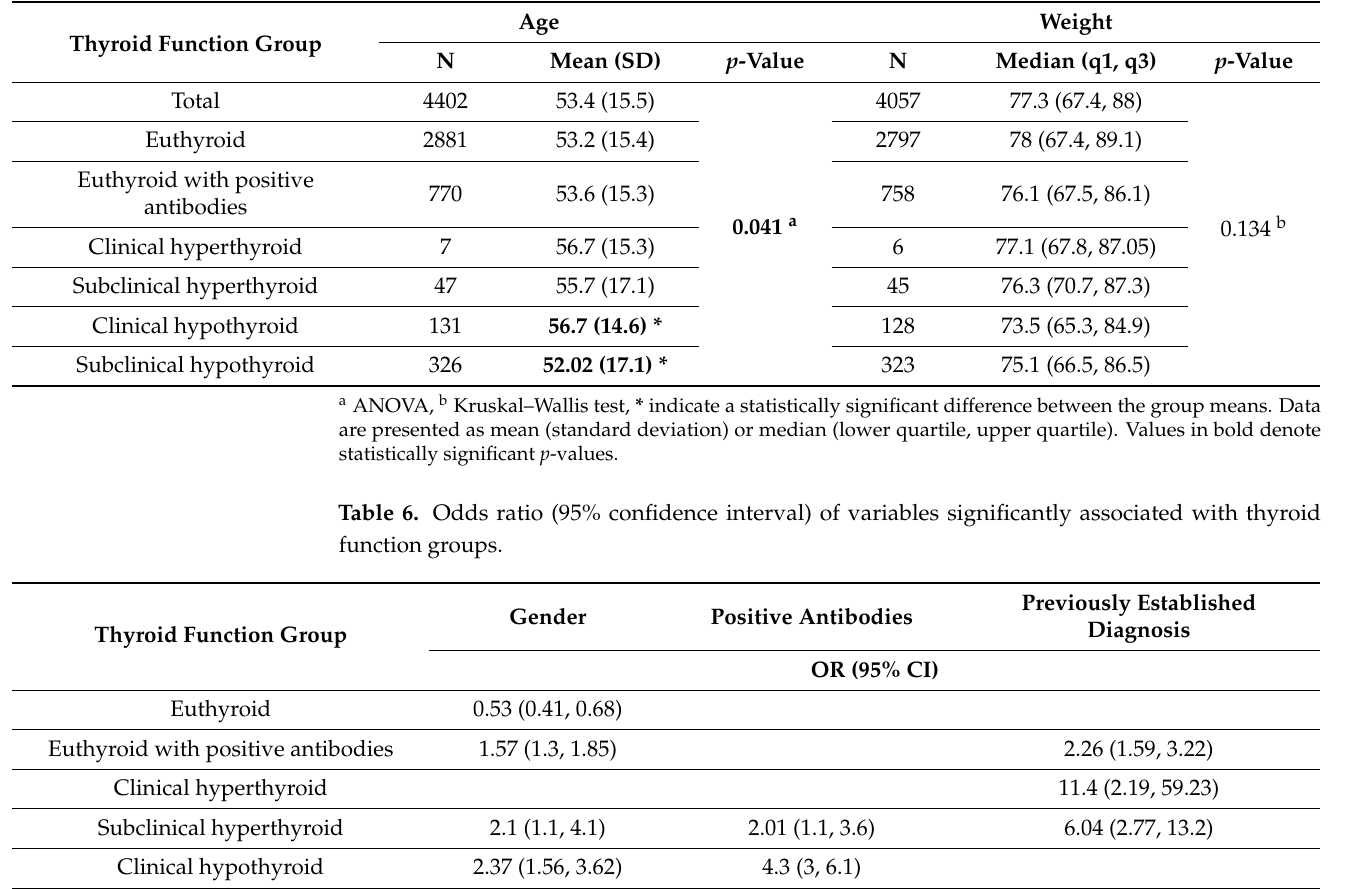
Table 5. Age and weight characteristics across thyroid function groups.